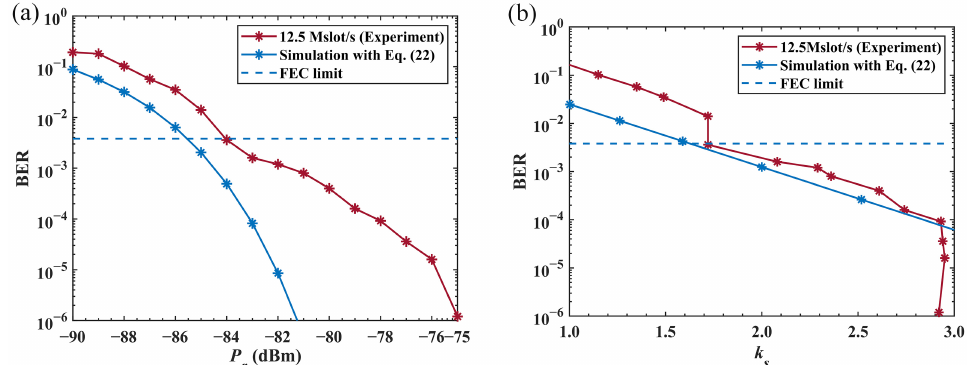
Figure 15. BER as functions of ( a ) received optical power P r and ( b ) photon counts k s .